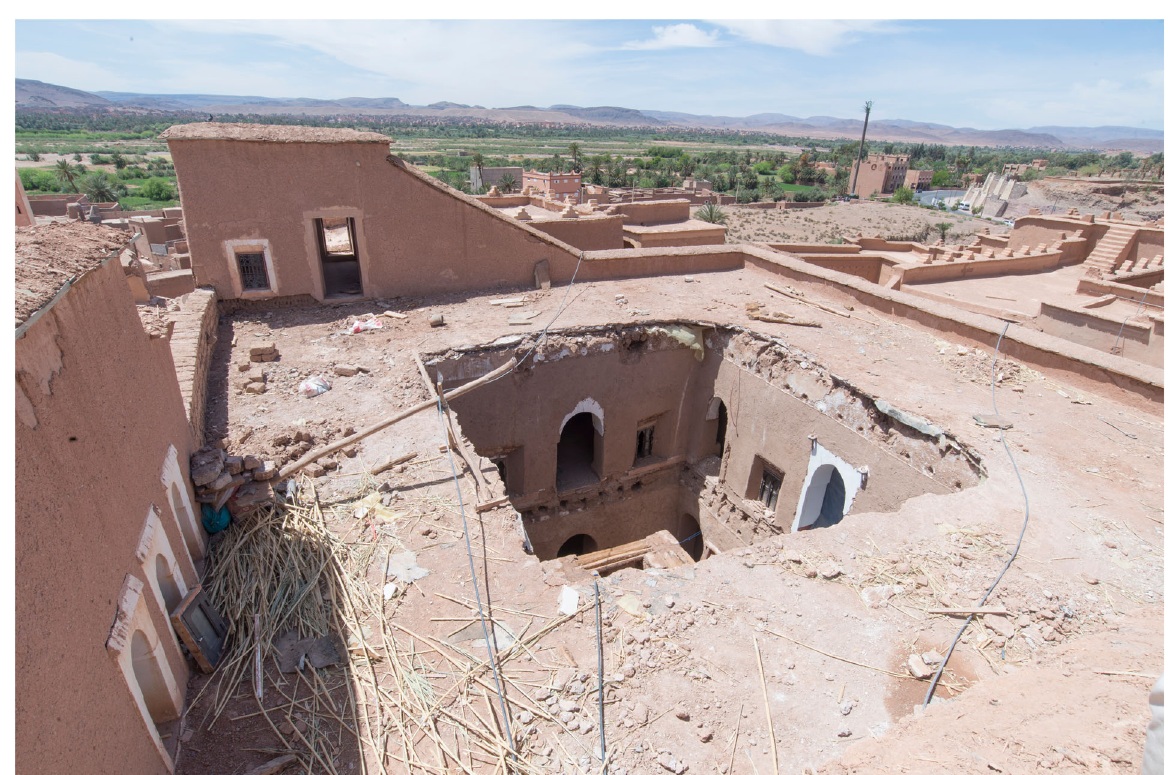
Fig. 3 Damage to earthen architecture structures from strong rains, Ouarzazate, Morocco (2016) (Source: the